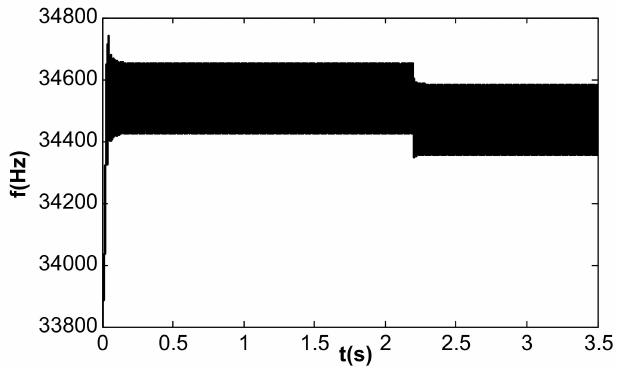
Figure 13. Jitter of the frequency tracking under single closed loop ( k II = 60).